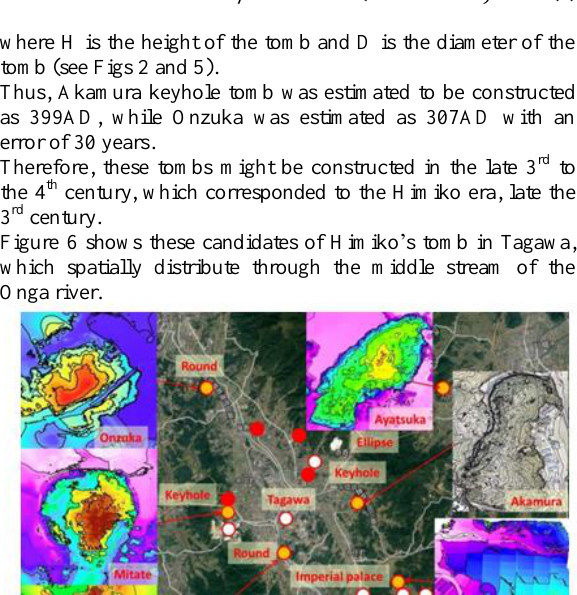
Table 3. List of rivers for countries